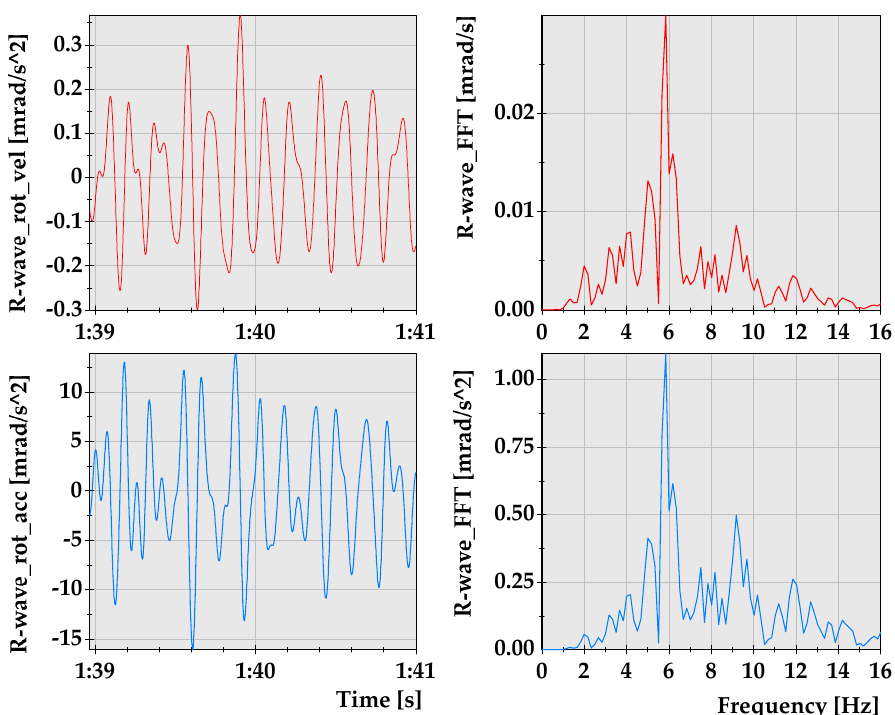
Figure 5. Velocity and acceleration characteristics of the R-wave generated by the mining tremor for the energy of 3.1 × 10 8 J.